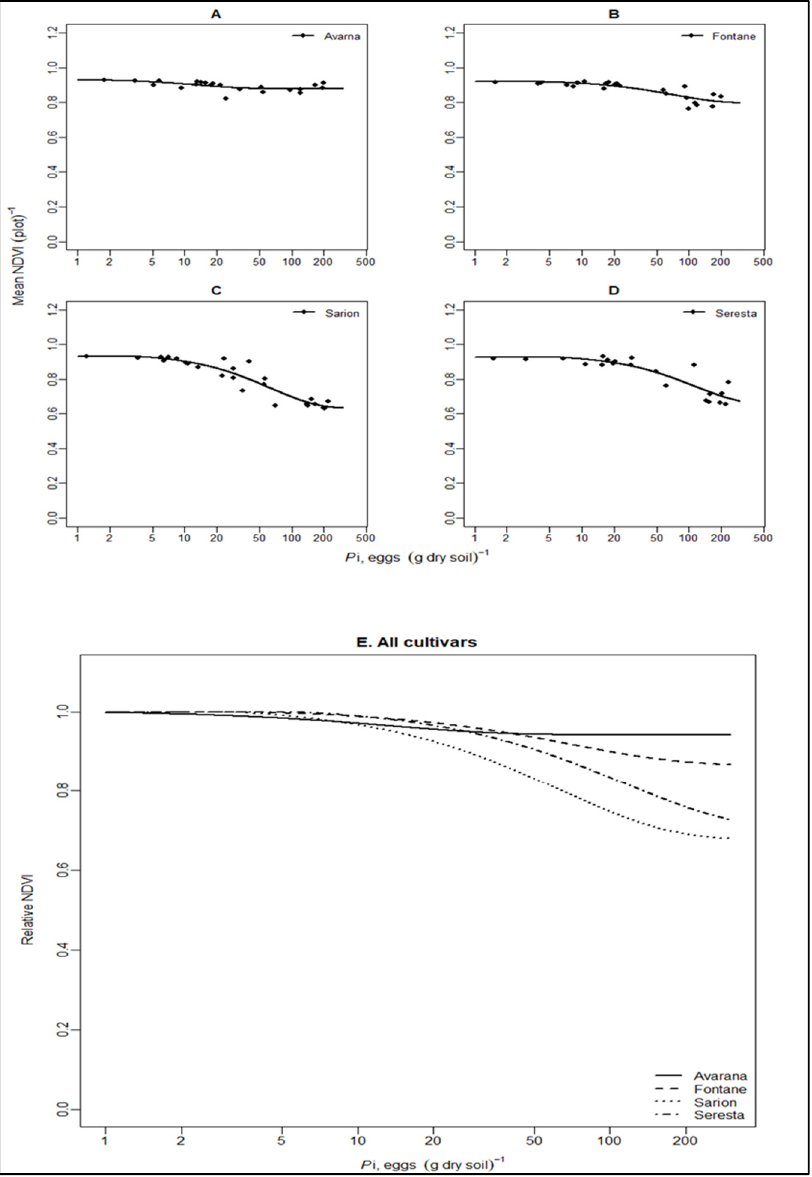
Figure 6. Relationship between the P i, eggs (g dry soil) − 1 and mean NDVI index of four potato cultivars according to Seinhorst yield model Equation (1). (( A ) Avarna. ( B ) Fontane. ( C ) Sarion. ( D ) Serresta.) ( E ) Relative NDVI of all the cultivars combined.